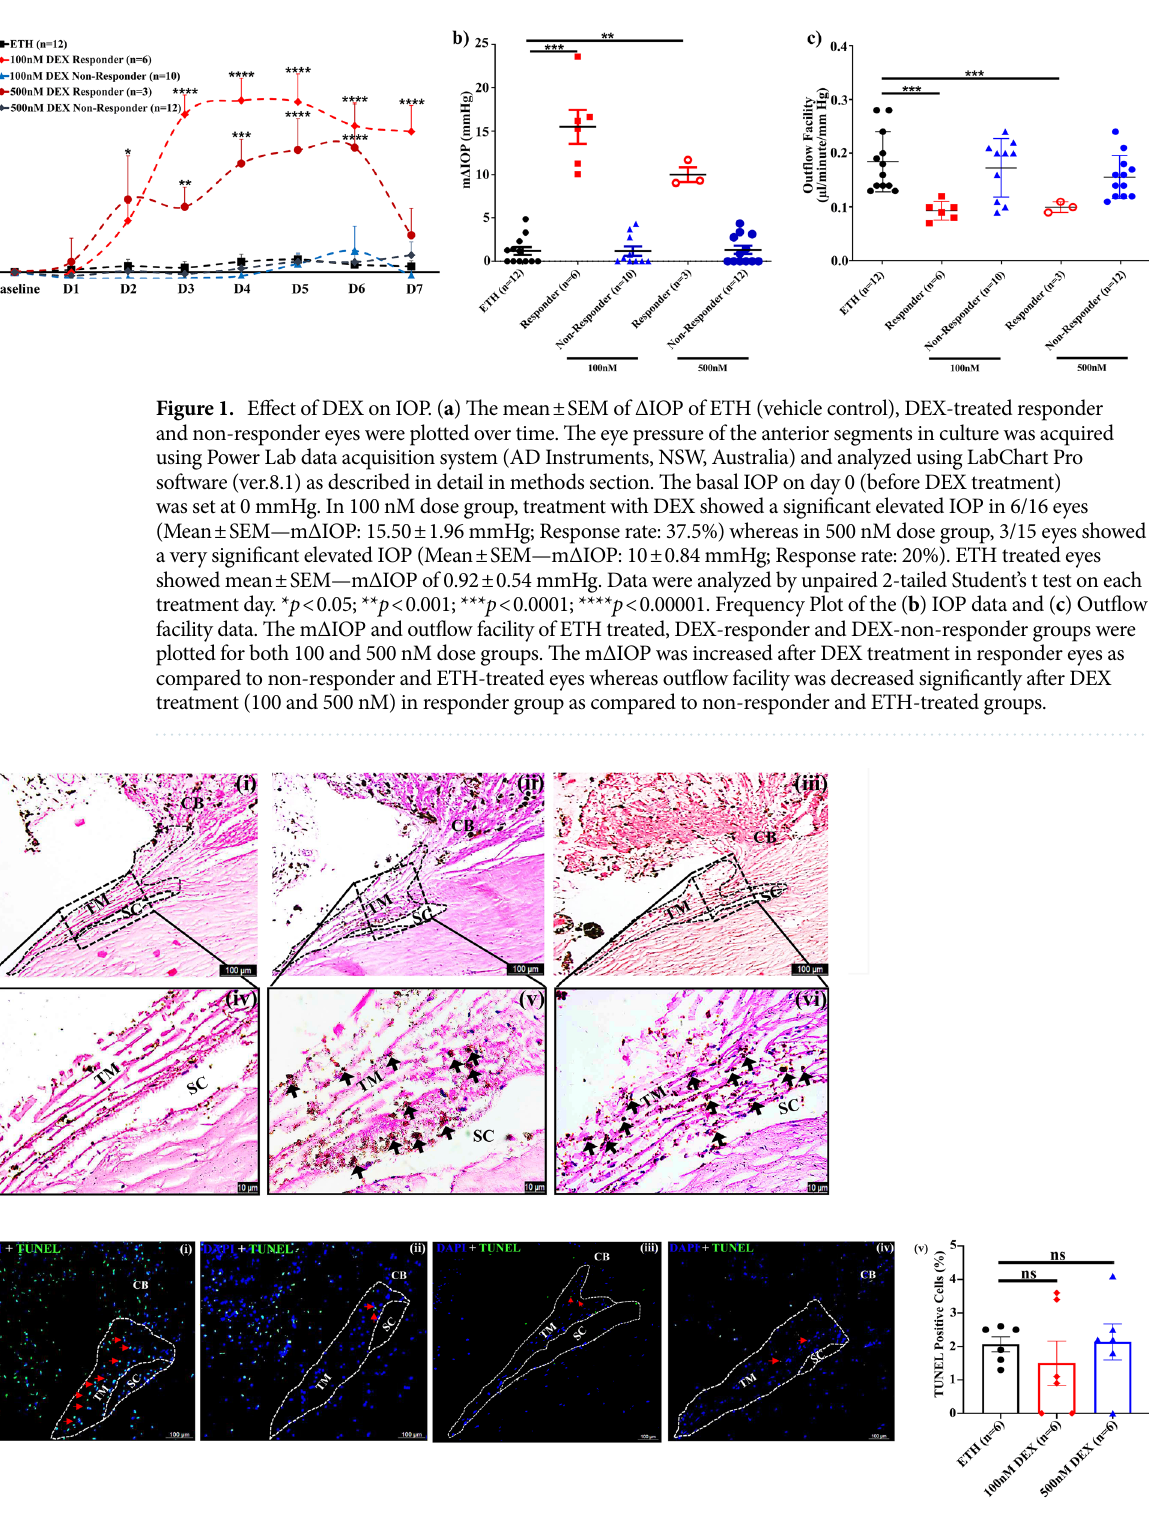
Figure 2. Effect of DEX on Morphology and Tissue viability. ( a ) Histology of Anterior Segment received (i, iv) 0.1% ETH, (ii, v) 100 nM DEX and (iii, vi) 500 nM DEX treatment for 7 days. High deposition of extracellular debris was found in DEX-treated eyes (indicated in black color arrow) (v, vi) as compared to vehicle-treated eyes (iv). ( b ) Representative images showing TUNEL positivity in (i) positive control (DNAase I treated), (ii) 0.1% ETH treated eyes, (iii) 100 nM DEX (iv) 500 nM DEX treated eyes and (v) Graph showing the percentage of TUNEL positive cells in ETH (n = 6), 100 nM DEX (n = 6) and 500 nM DEX-treated eyes (n = 6). No significant toxicity was observed after DEX treatment. The TUNEL positivity is indicated in red color arrow. TM-Trabecular meshwork; SC-Schlemm’s canal and CB- Ciliary